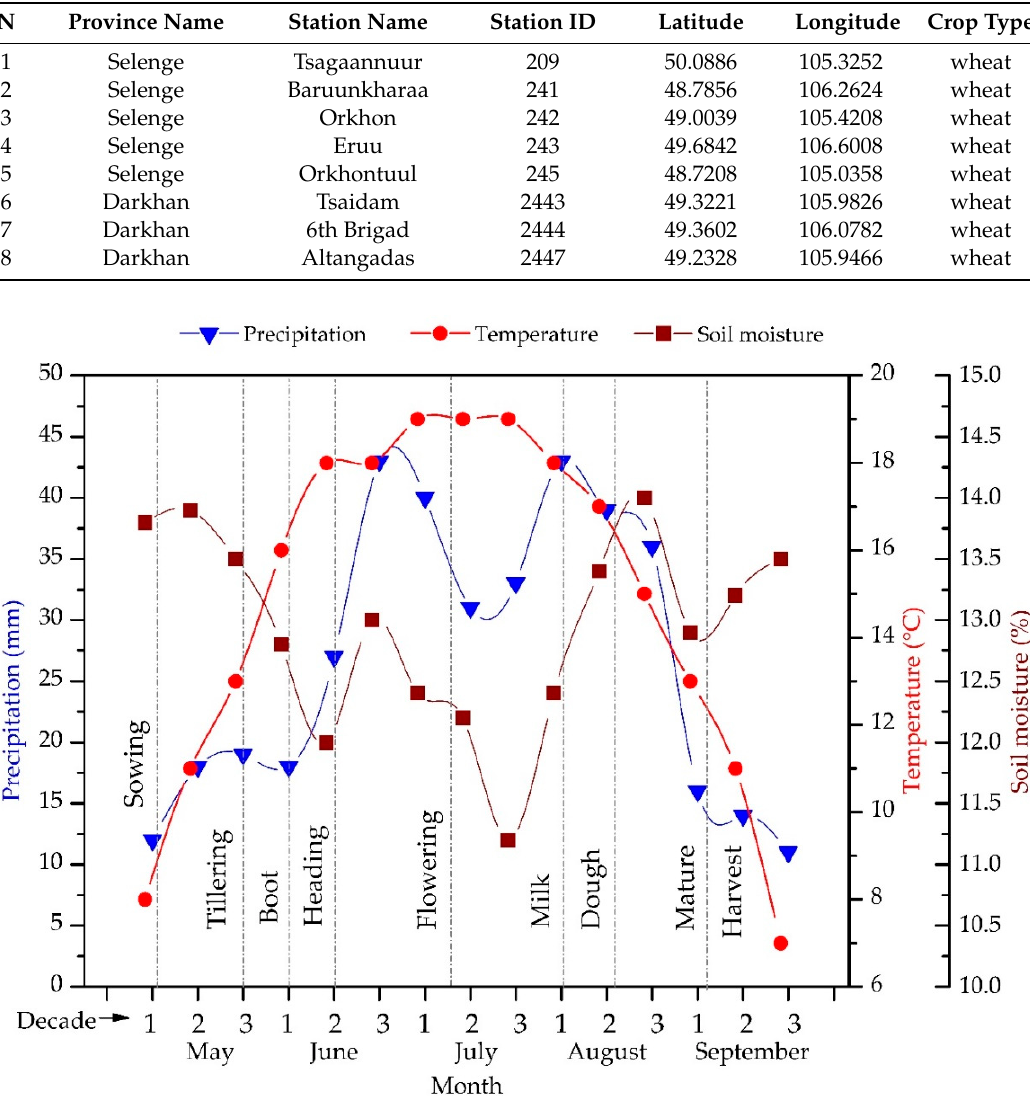
Figure 3. Growing stage of spring wheat and climate variables distribution in the study area.